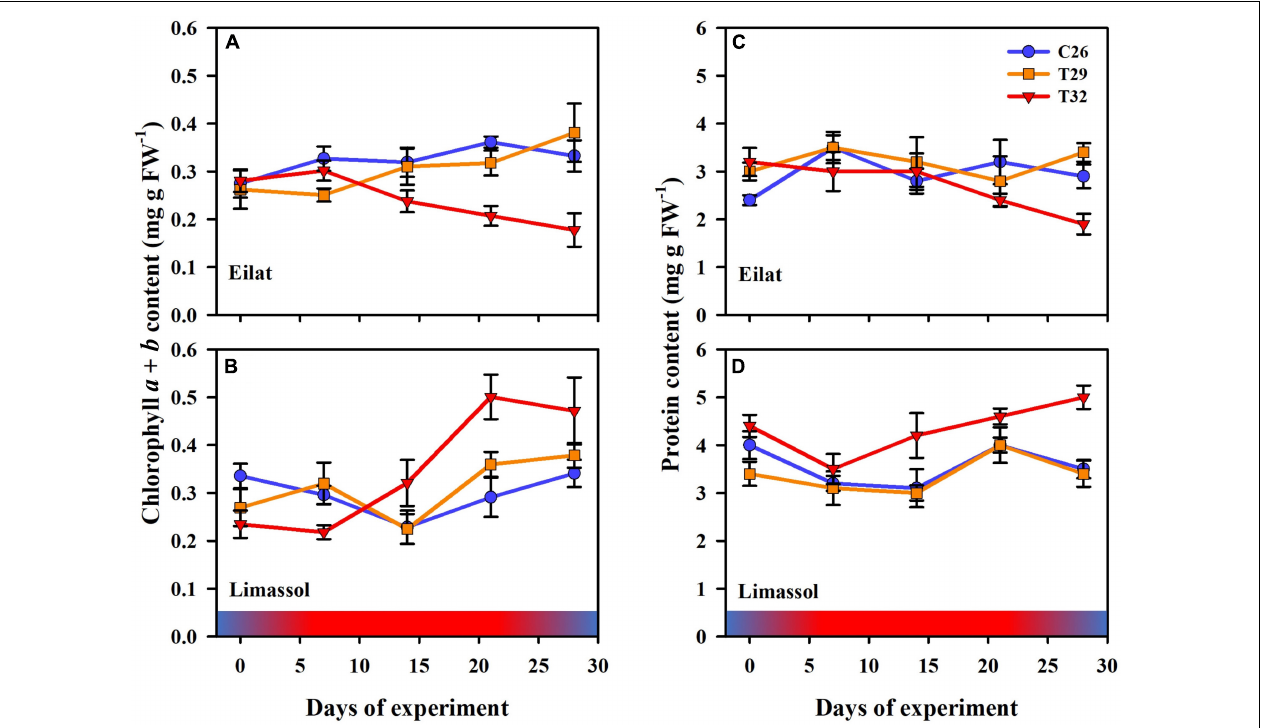
FIGURE 5 | Effects of a simulated heat wave on plant biochemical indicators of native (A,C) vs. invasive (B,D) populations of H. stipulacea . Shown are changes over time (days of the experiment) in the (A,B) chlorophyll a and b , and (C,D) protein contents. In all parameters, results represent n = 5, mean ± SE. Gradient color bars indicate the experimental heat